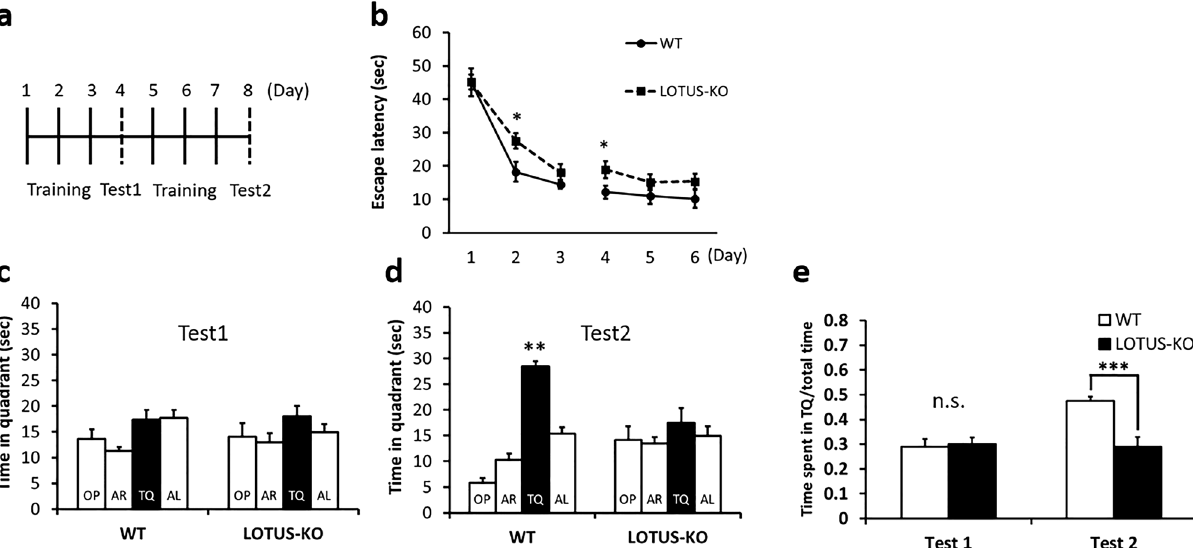
Figure 5. Loss of LOTUS causes impairment in spatial learning. ( a ) Time course of the experimental procedure of the Morris Water Maze test. ( b ) Escape latency time in WT and LOTUS-KO mice. Data are means ± SEM from WT mice (n = 15) and LOTUS-KO mice (n = 13). * P < 0.05, Student’s unpaired t -test. ( c ) Test in WT and LOTUS-KO mice after training for 3 days. Data are analyzed by χ 2 test. ( d ) Test in WT and LOTUS-KO